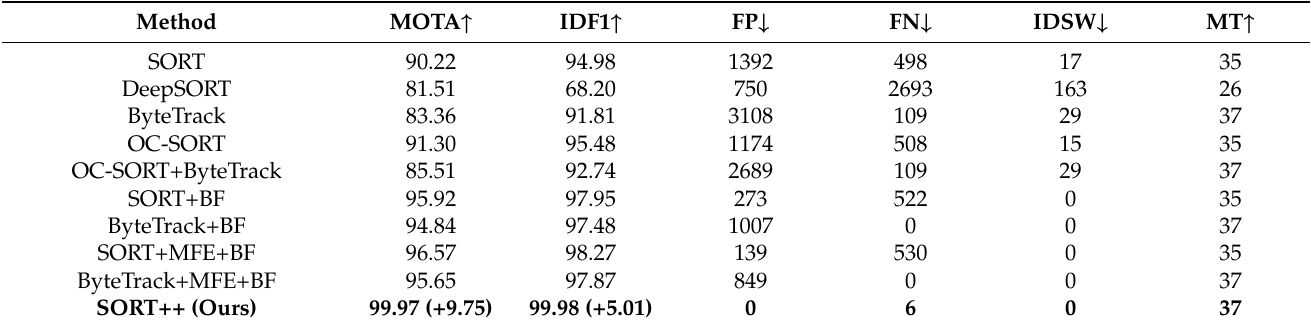
Table 10. Comparison of the state-of-the-art methods on the Test2 (Rainy) set.